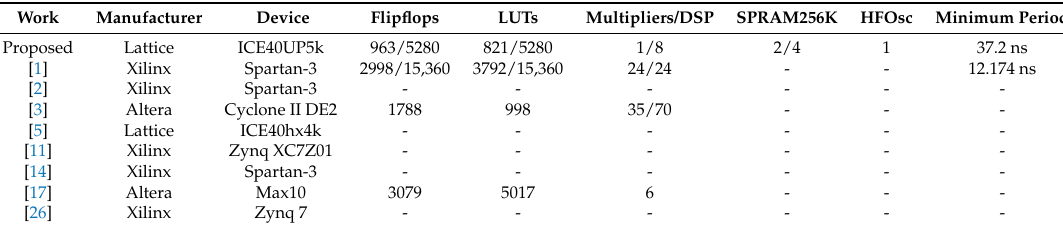
Table 1. Logic resources